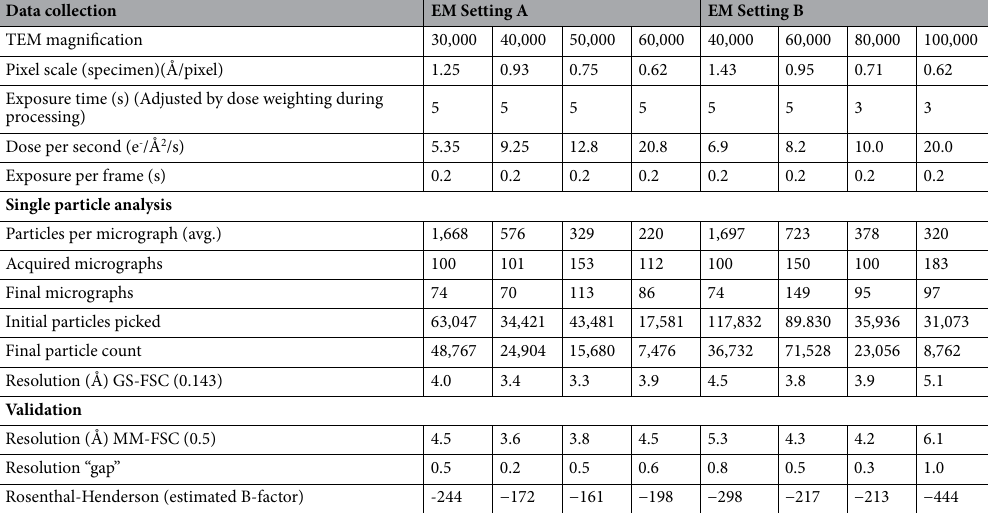
Table 1. Details of each of eight acquisition conditions.